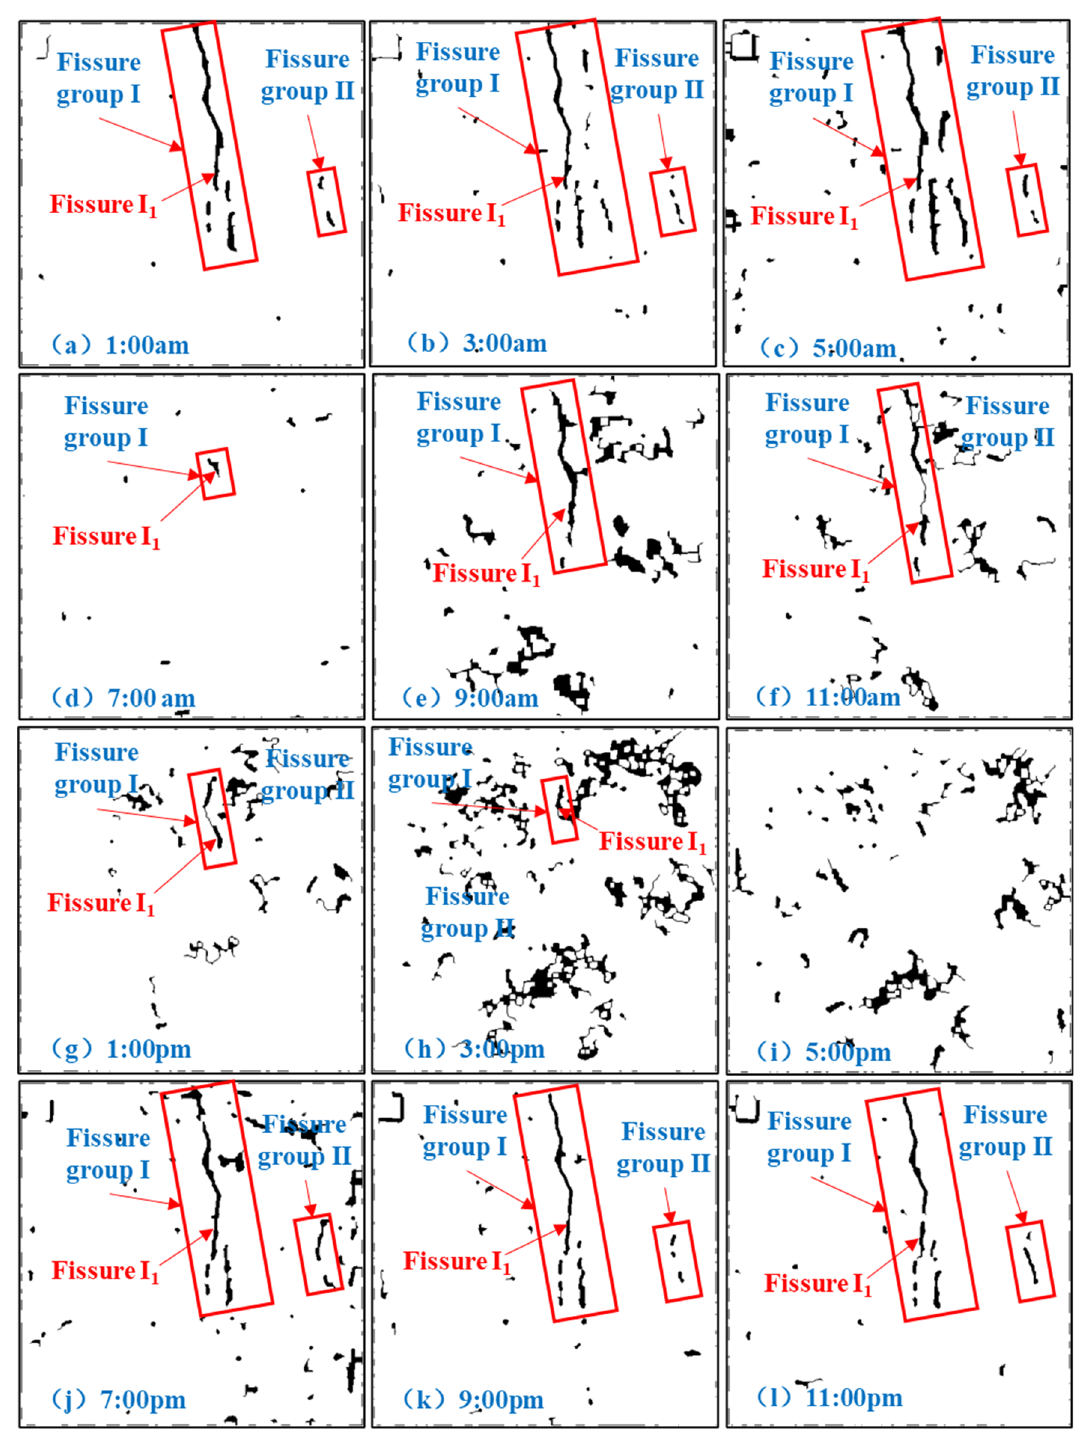
Figure 11. Results of fissure detection in infrared images at different time points using the proposed method. ( a ) 1:00 a.m.; ( b ) 3:00 a.m.; ( c ) 5:00 a.m.; ( d ) 7:00 a.m.; ( e ) 9:00 a.m.; ( f ) 11:00 a.m.; ( g ) 1:00 p.m.; ( h ) 3:00 p.m.; ( i ) 5:00 p.m.; ( j ) 7:00 p.m.; ( k ) 9:00 p.m.; ( l ) 11:00 p.m.